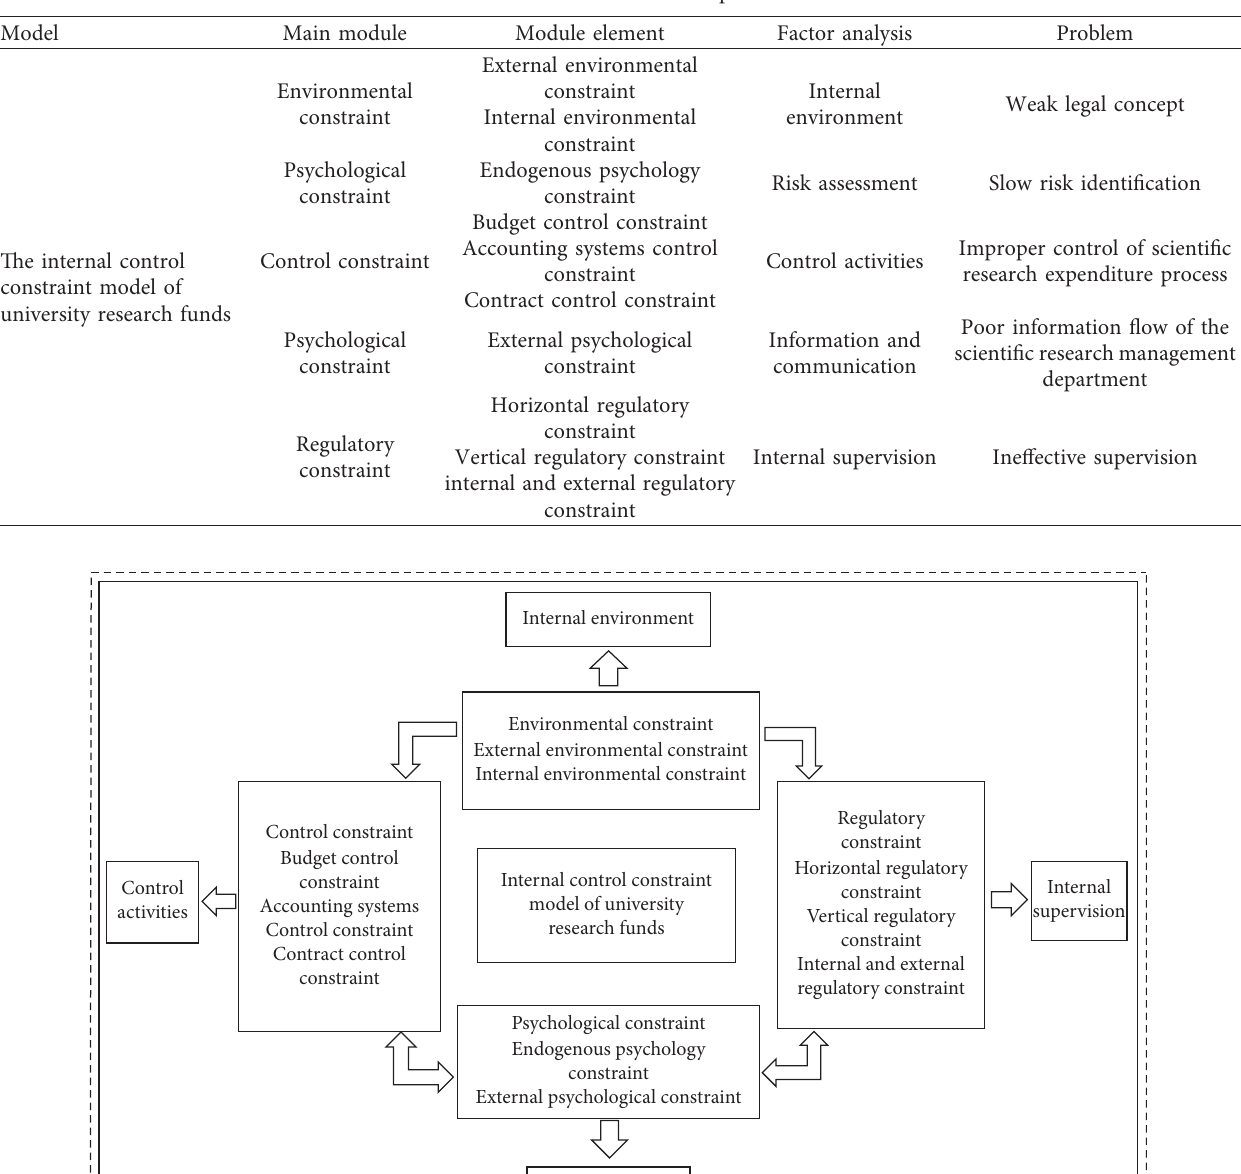
Table 2: Model construction process.